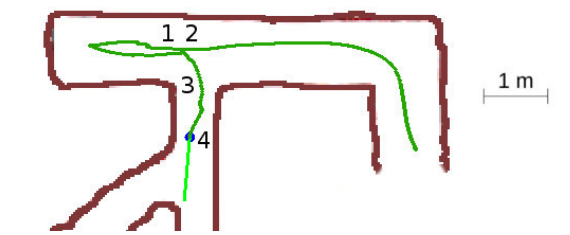
Figure 19. Explored three-way crossing